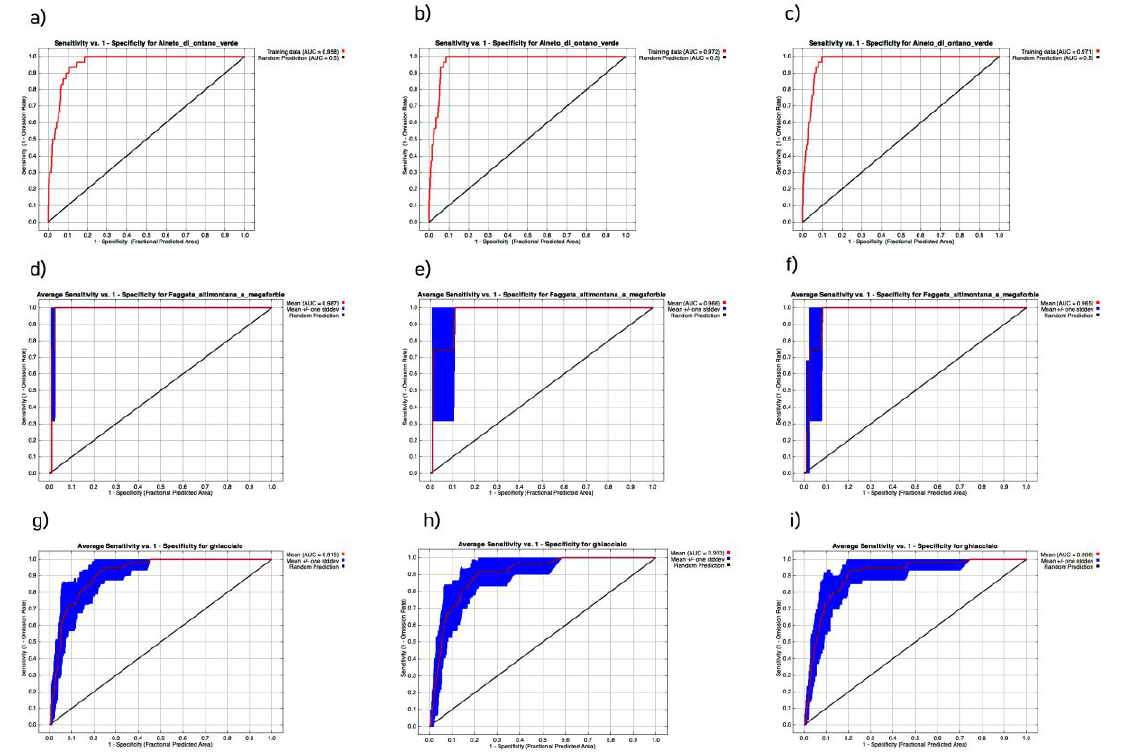
Figure 4. Receiver operating characteristic (ROC) curve of the three scenarios and environmental indicators. ( a ) ROC curve of past, ( b ) present and ( c ) future scenarios for Alnus viridis ; ( d ) ROC curve of past, ( e ) present and ( f ) future scenarios for altimontane beech forest; ( g ) ROC curve of past, ( h ) present and ( i ) future scenarios for glaciers.